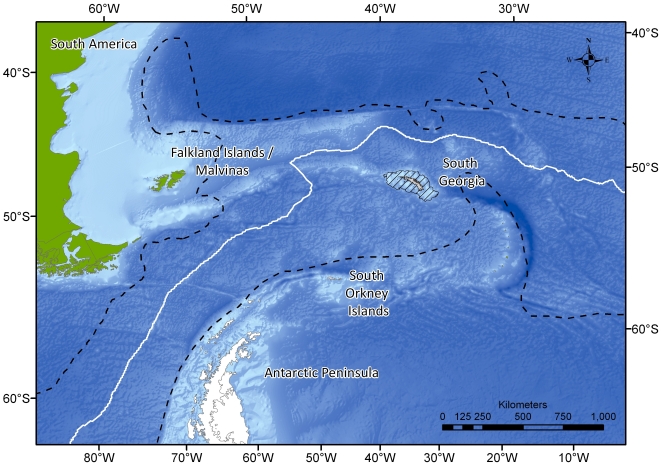
The position of South Georgia relative to the Polar Front (white line), and the Antarctic Circumpolar Current (black dashes).